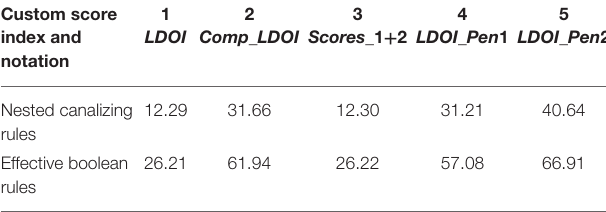
TABLE 1 | Mean number of solutions found for each target set and random network pair for 50 target sets and 1,000 networks. Custom score index